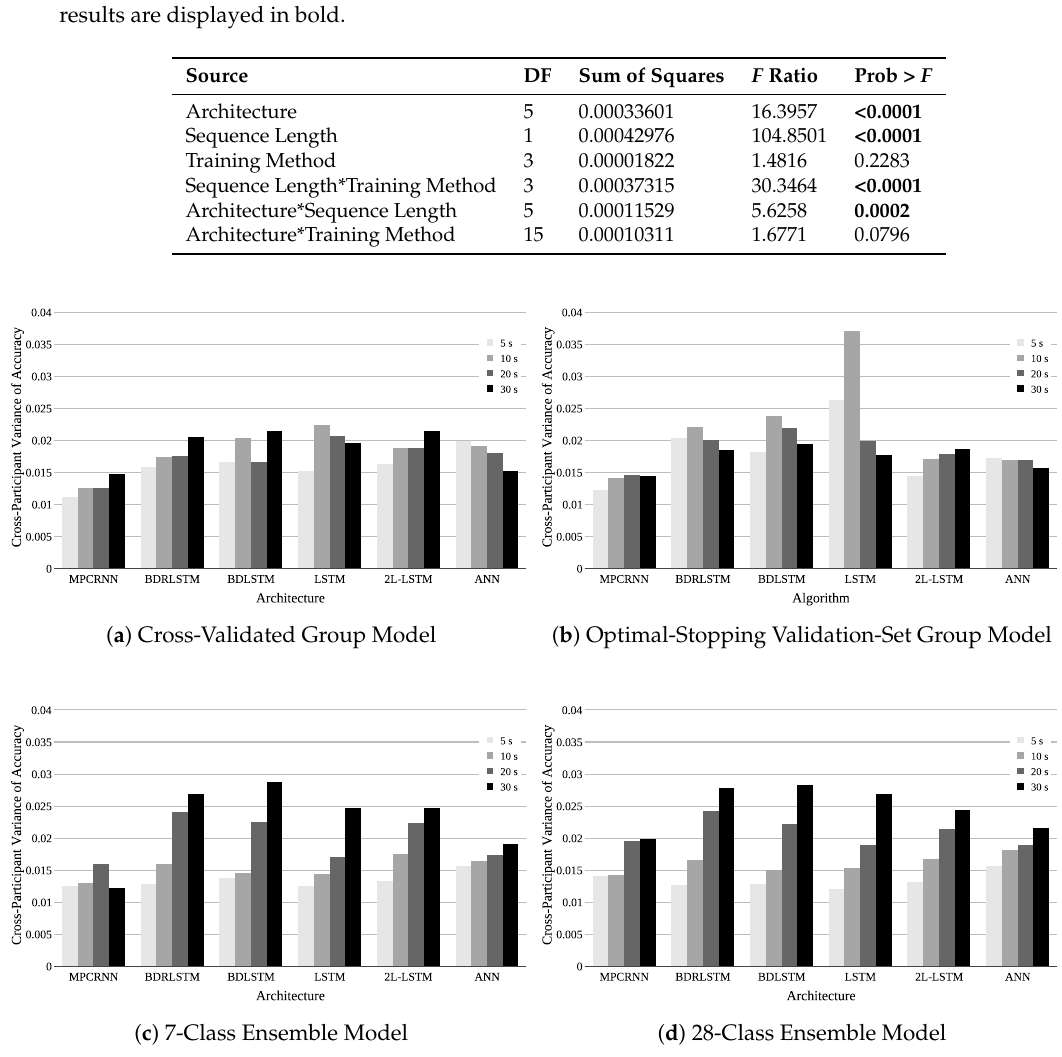
Figure 6. The plots of cross-participant variance of classification accuracy per architecture and sequence length show how much variance there was across-participants for a given training